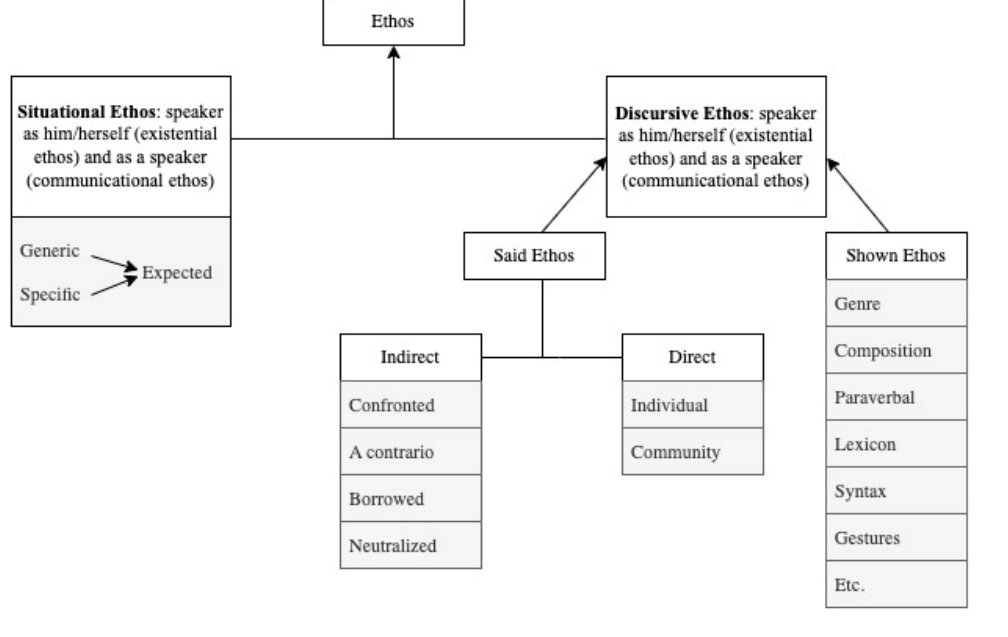
Figure 1. Ethos types.